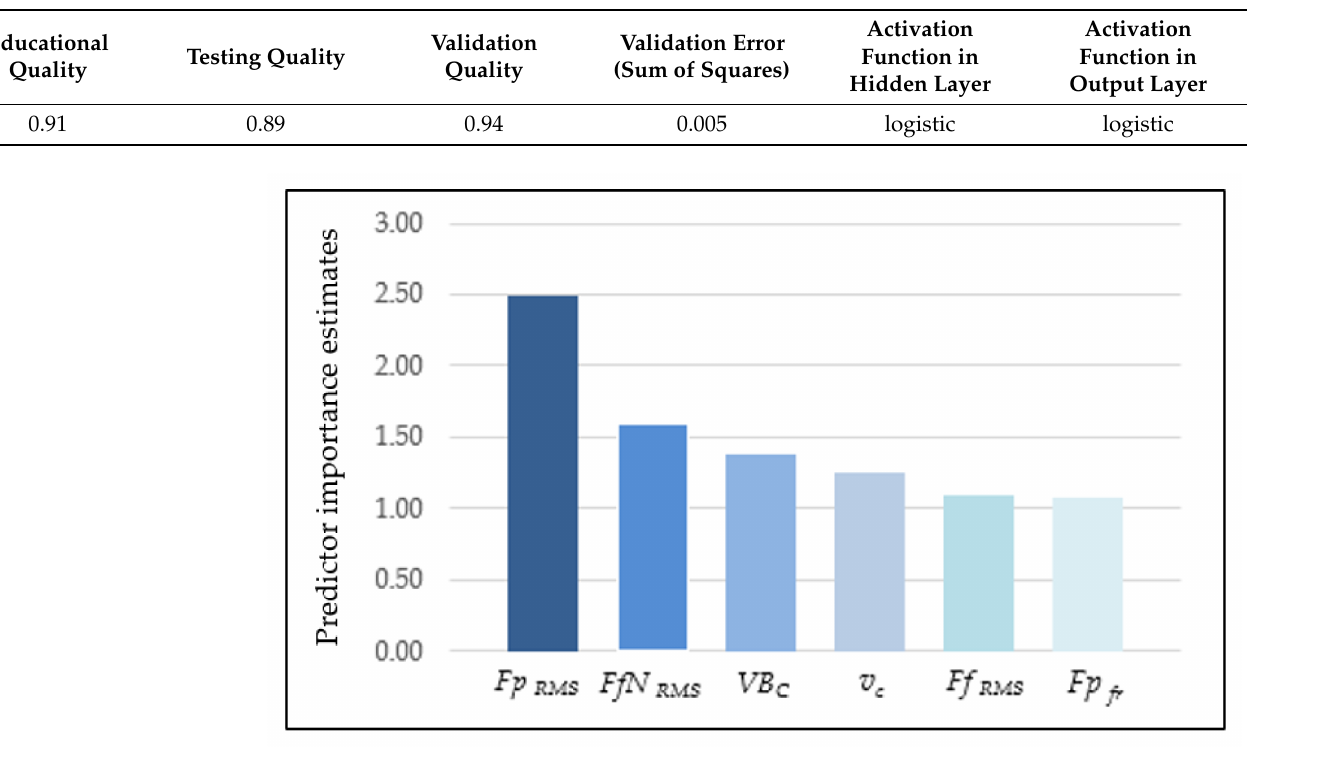
Figure 16. Validity of input parameters on surface roughness (ANN).